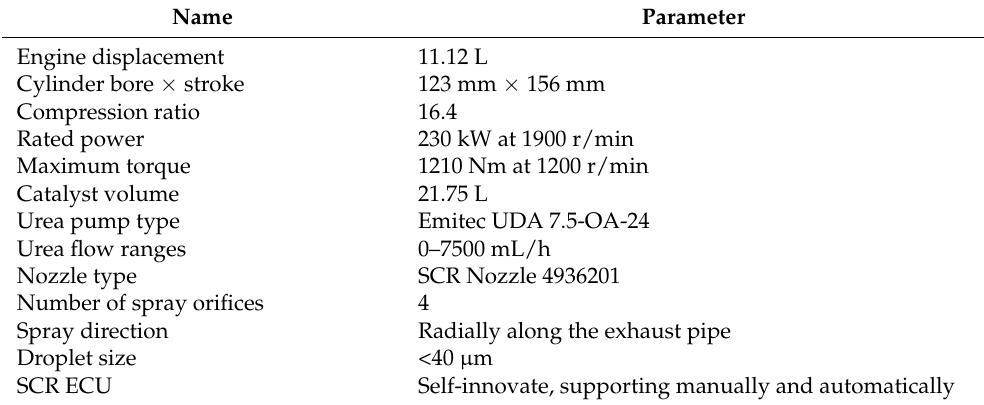
Table 1. Basic parameters of the diesel engine and SCR system.